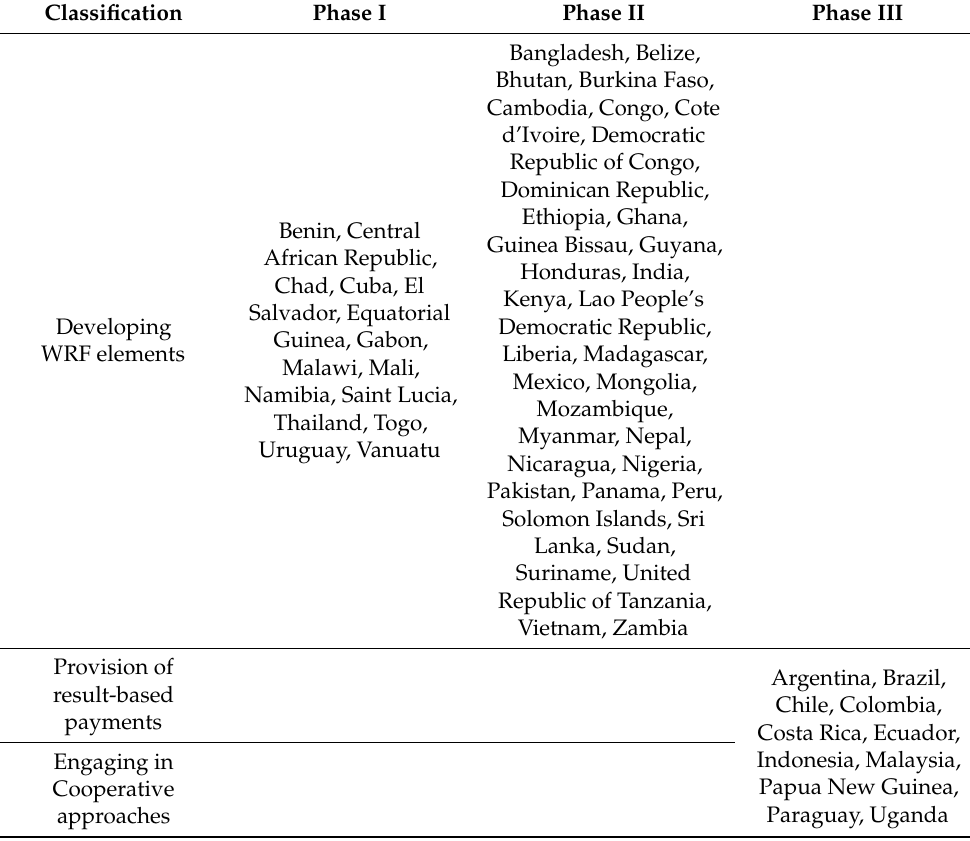
Table 8. Classification of countries by REDD+ progress and possible financing